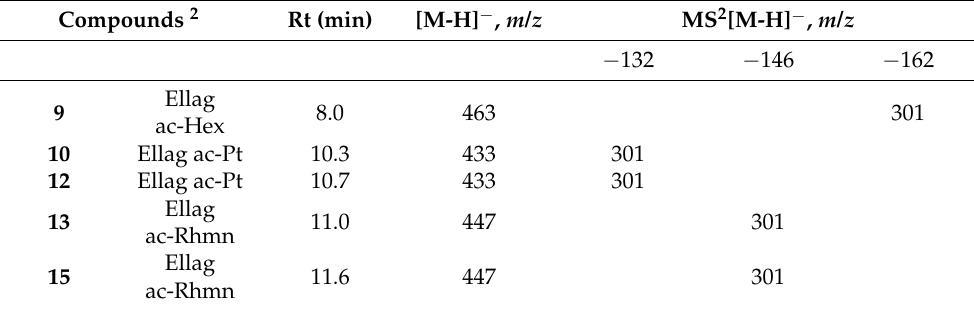
Table 1. Rt, Molecular Formula, [M-H] − and MS2 [M-H] − data for the ellagic acid derivatives detected in methanolic extracts of A. chilensis leaves 1 .